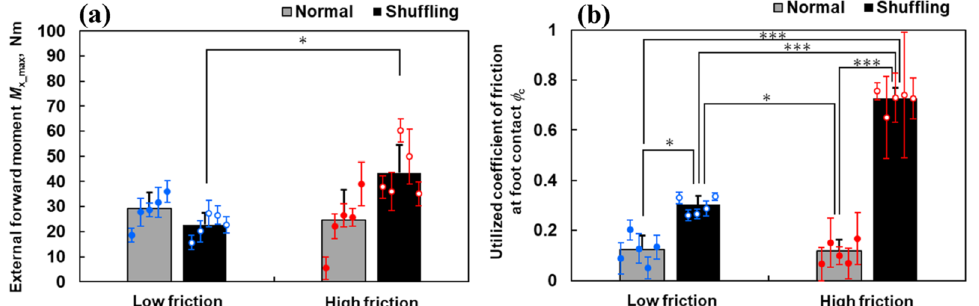
Figure 6. Comparison of mean and SD values of ( a ) M x _ max and ( b ) under the low- and high-friction conditions. Error bars around each plotted point represent SD values around each subject’s mean. ** p < 0.01, *** p <